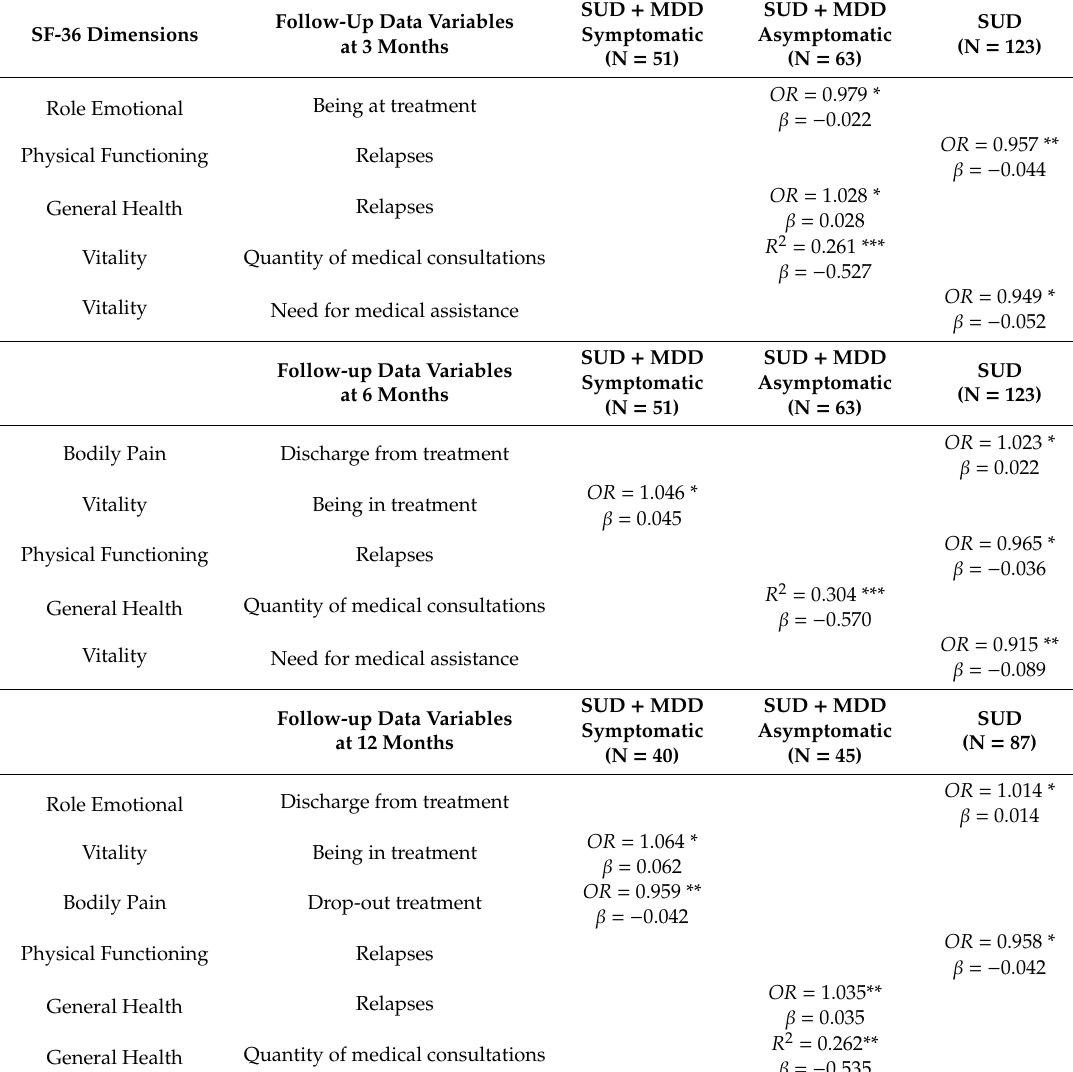
Table 5. Results from the logistic and linear regression models for health-related quality of life dimensions and follow-up data at 3, 6, and 12 months for the